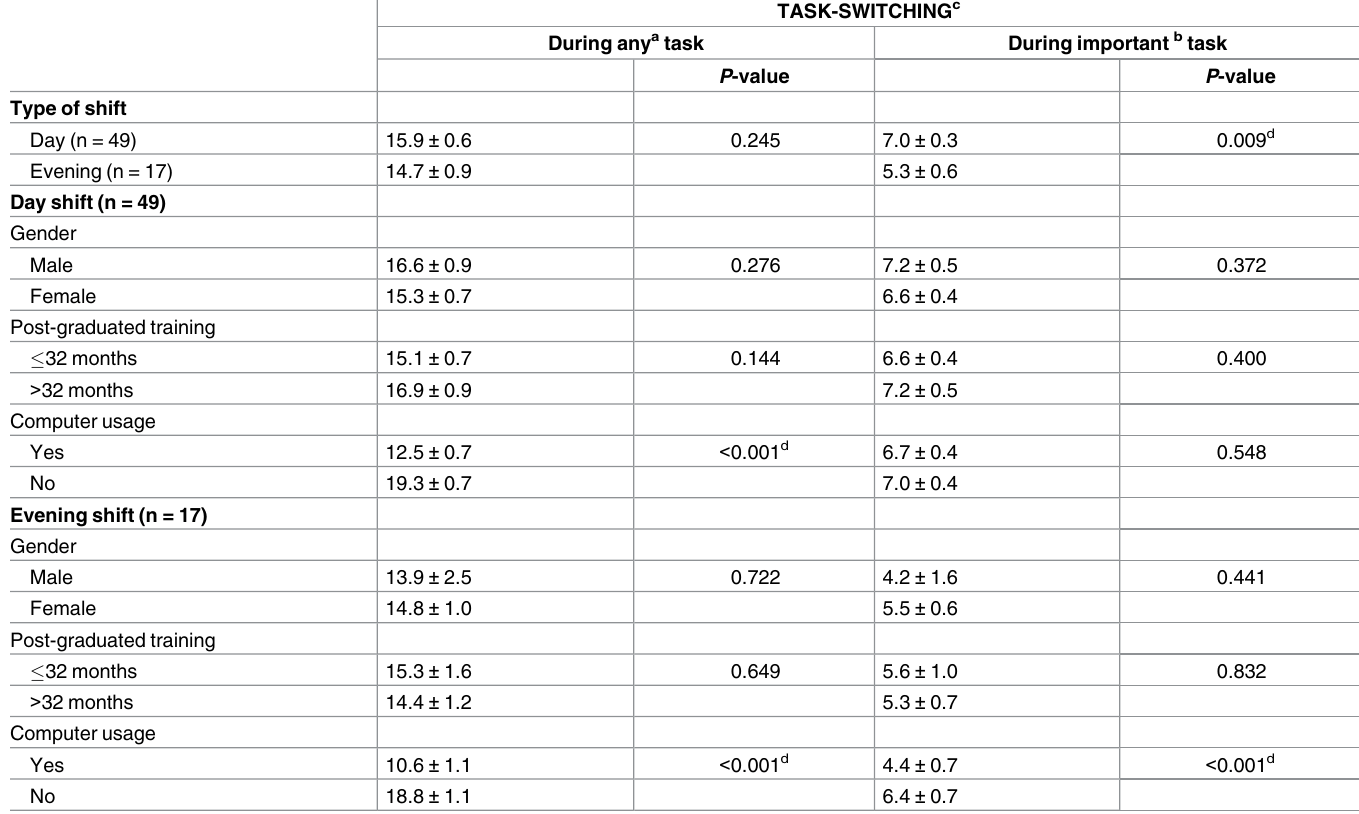
Table 1. Factors associated with hourly rate of task-switches, overall and stratifying by type of